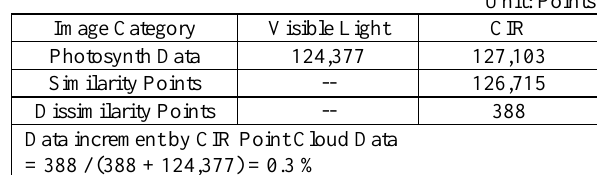
Table 2. Multispectral point cloud increment information